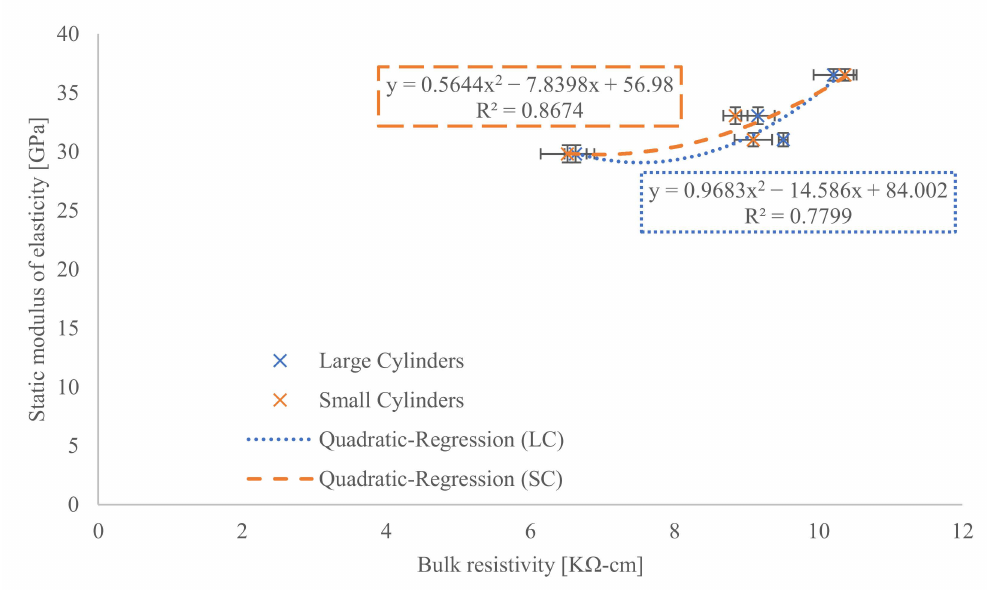
Figure 12. Quadratic regression analysis of the relationship between bulk electrical resistivity and dynamic modulus of elasticity (LC = Large Cylinders, SC = Small Cylinders).